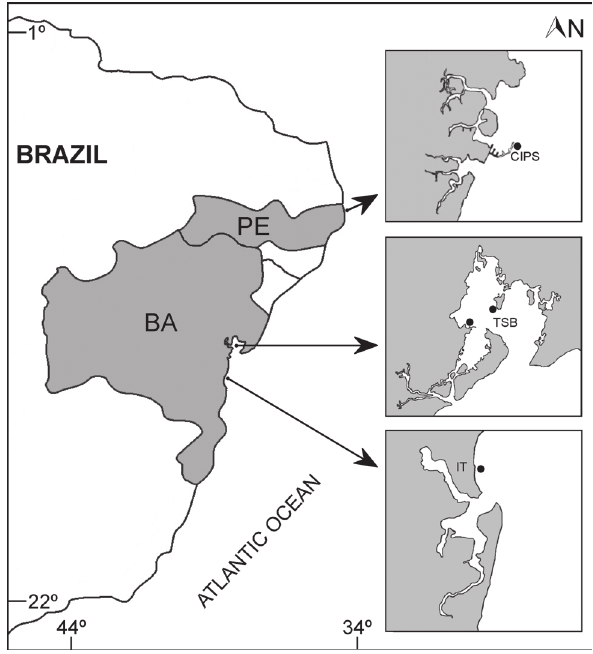
Figure 1. Distribution map of Triphyllozoon arcuatum in Brazilian coast. Legends: PE, Pernambuco State; BA, Bahia State; CIPS, In- dustrial Port Complex of Suape; TSB, Todos os Santos Bay; IT,